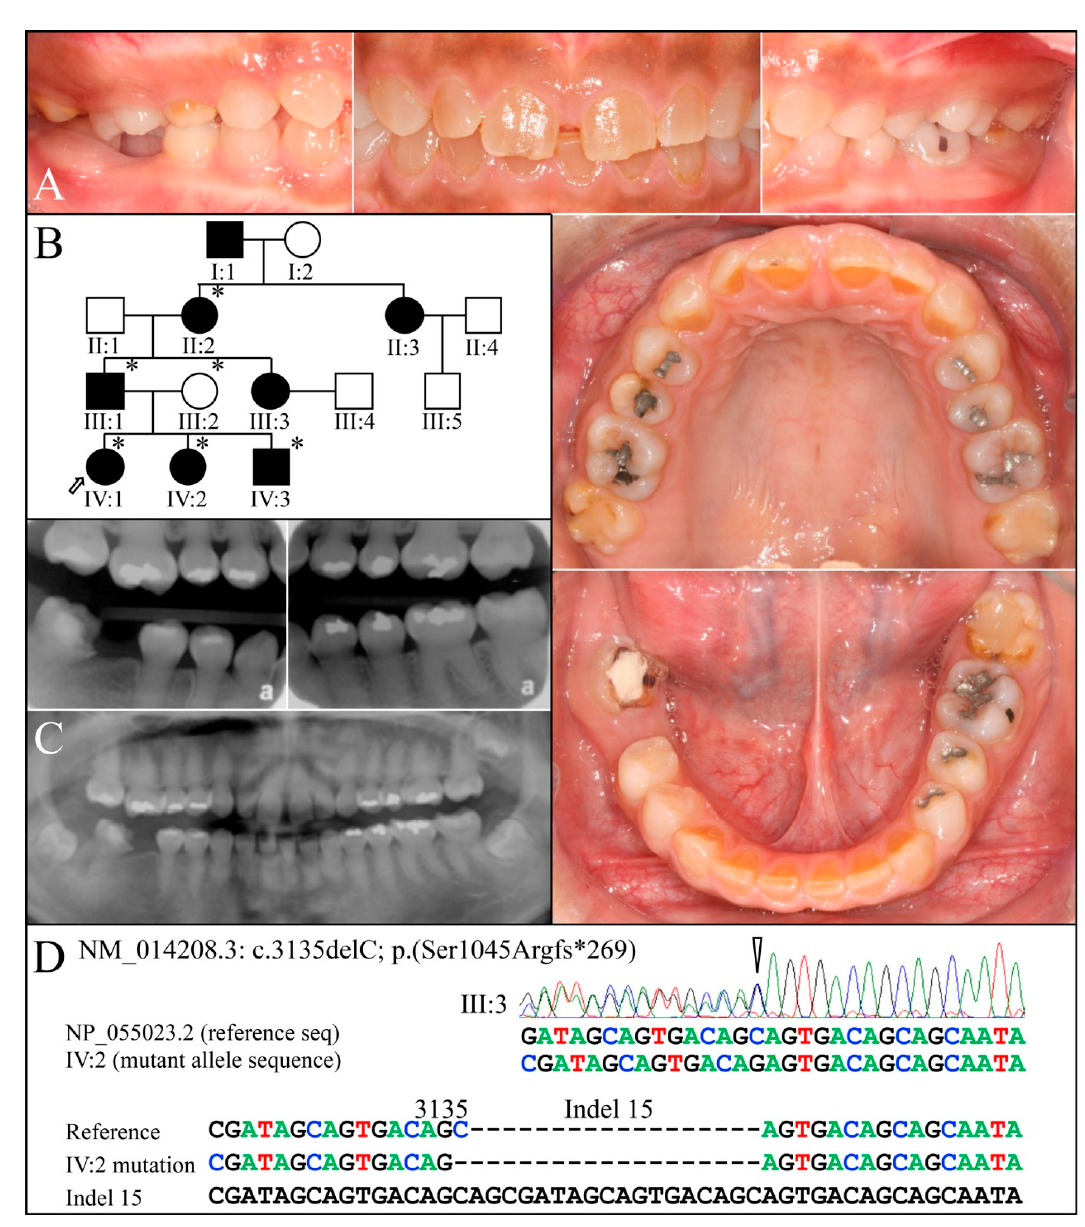
Figure 13. Family 10. ( A ): Clinical photos of the proband (IV:1) at age 14-years 4-months. ( B ): Four- generation pedigree showing dominant inheritance and identifying the six recruited members (aster- isks). ( C ): Bitewing and panoramic radiographs of proband taken at age 14-years 4-months showing bulbous molar crowns and obliterated pulp chambers and canals. ( D ): DNA sequence chromatogram showing the heterozygous DSPP − 1 frameshift (c.3135delC, p.Ser1045Argfs*269) that segregated with the dental phenotype. Key : * denotes enrolled